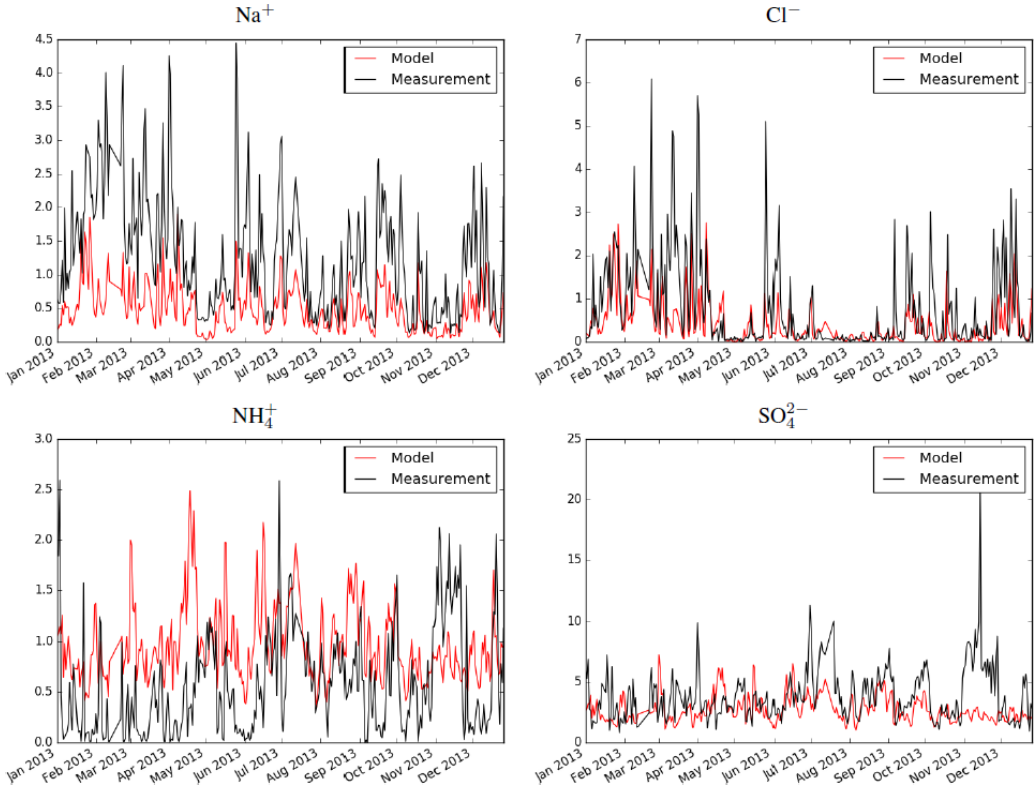
Figure 14. Modeled (red) and measured (black) concentrations of Na + , Cl − , NH +